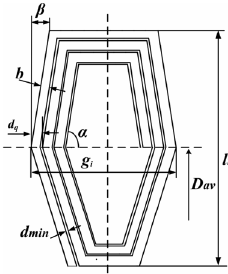
Figure 26 3-D finite simulation model of a hexagon PCB